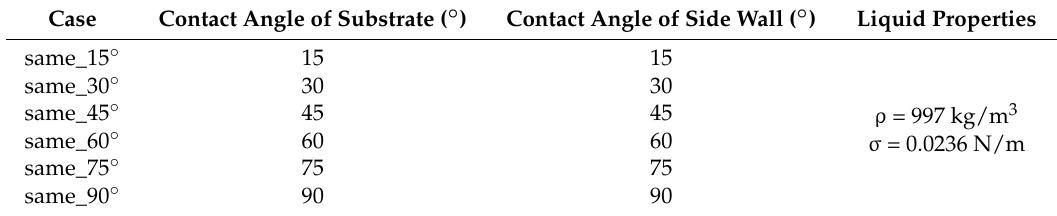
Table 1. Parameters used in the simulation cases under the same wetting conditions.